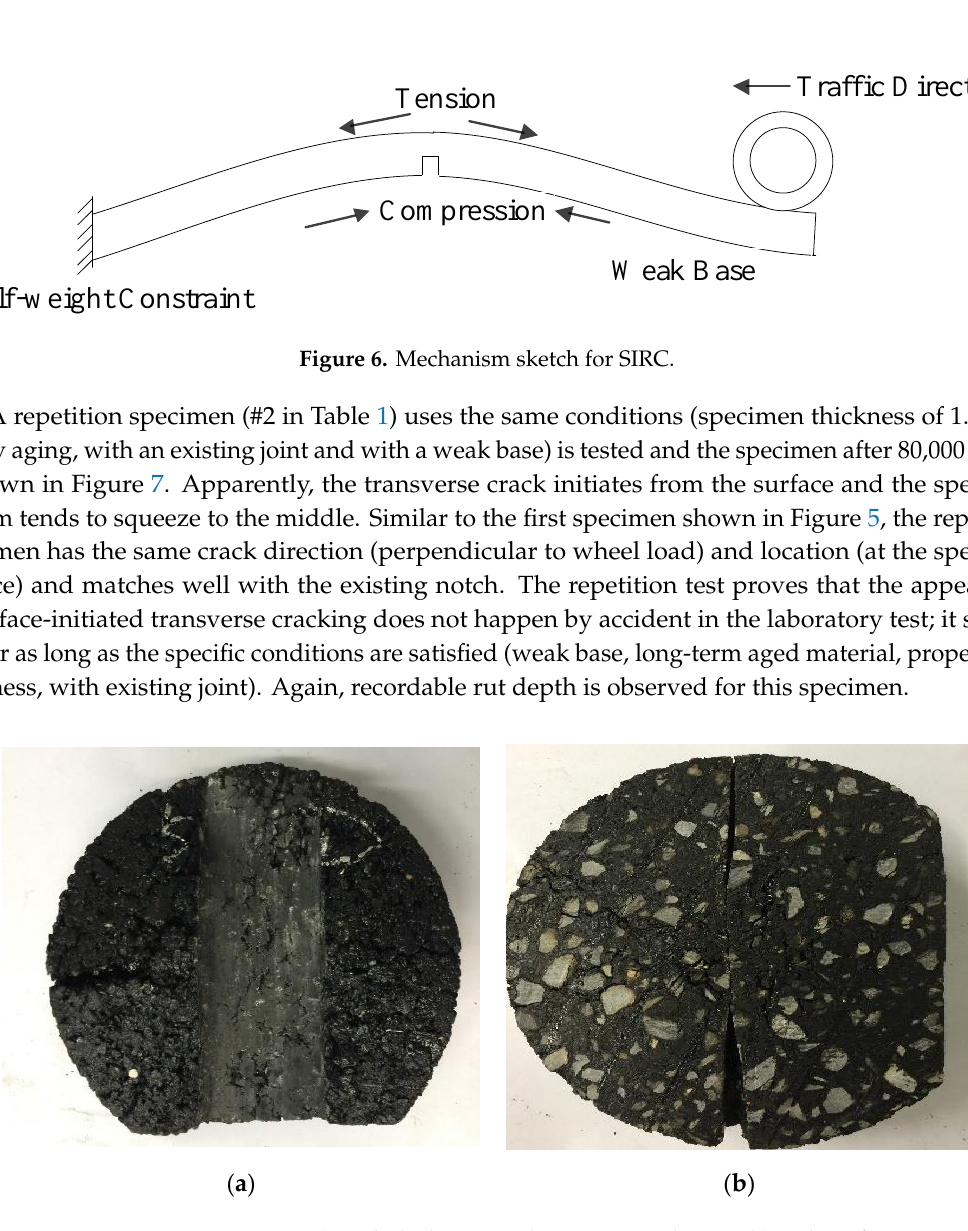
Figure 7. Repetition specimen #2 (1-inch thickness, 10 days aging, with a notch) with surface-initiated transverse cracking, ( a ) specimen top and ( b ) specimen bottom .